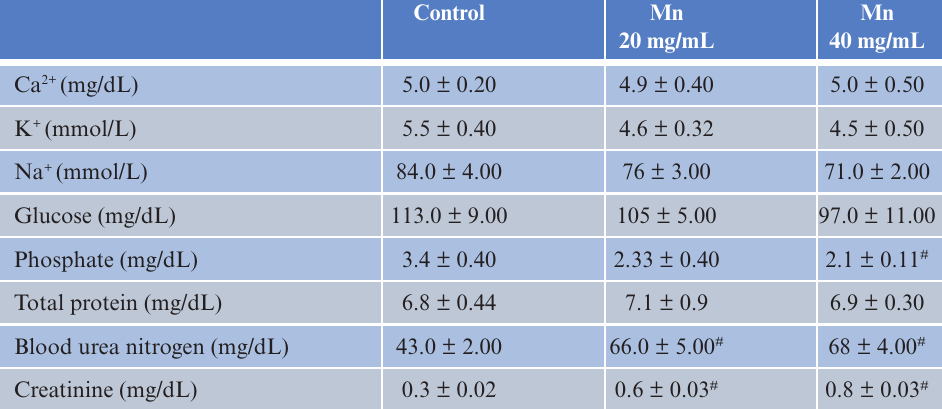
Table 1. Serum biochemical measurements in manganese (Mn)-treated rats.